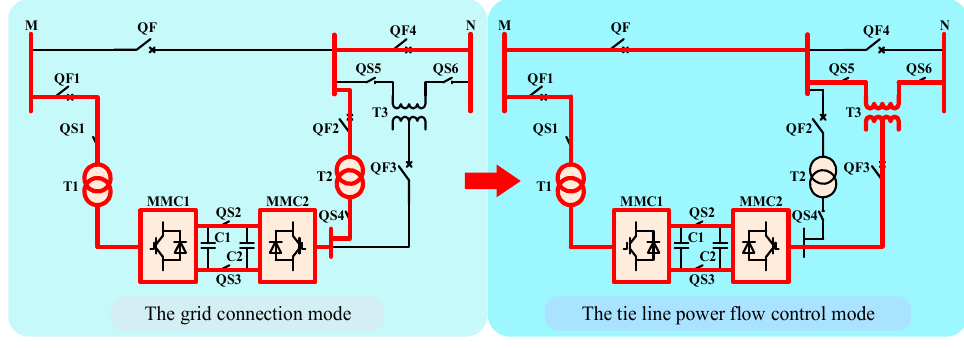
Figure 1. The topology of the GCCD.